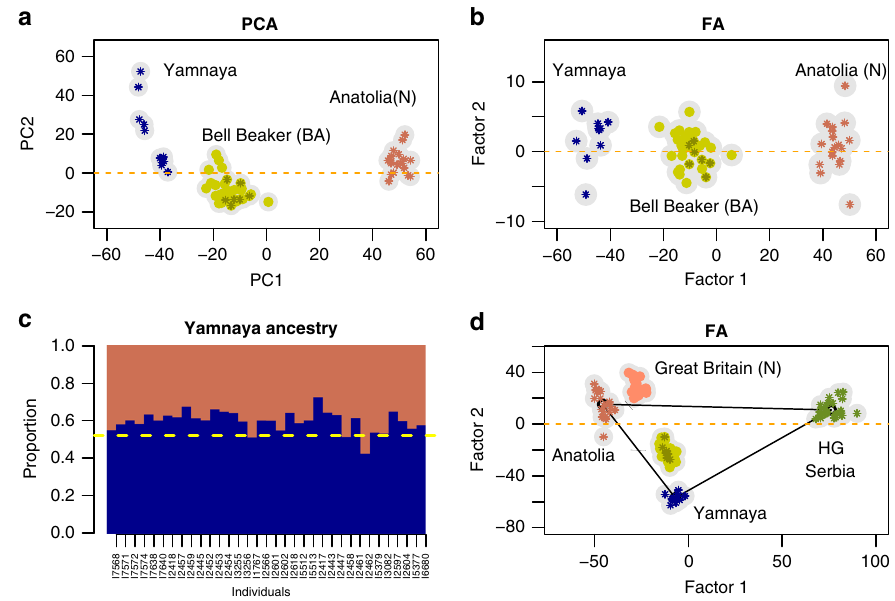
Fig. 4 Analysis of 34 samples from Bronze Age England. a The PCA of Bronze Age, Steppe and Early Farmer samples exhibits a horseshoe pattern, b FA for the samples, c Steppe ancestry estimates for Bronze Age England samples computed from Factor 1 (x-axis: sample IDs). The dashed line corresponds to the estimate computed by the qpAdm program using Yamnaya Samara and Anatolia (N) as ancestors, and Yoruba, Russia Sidelkino (EHG), France-Ranchot (WHG) as outgroups, d FA of samples from Bronze Age and Neolithic Great Britain with three ancestral groups. The ticks on the triangle sides indicate the proportions of ancestry from HG and Yamnaya. Samples: EBA (Early Bronze Age): 11, EBA Bell Beaker: 16, MBA (Middle Bronze Age, dark green stars): 7, Great Britain (N) Neolithic England and Scotland: 28, HG (Hunter Gatherers, Serbia):